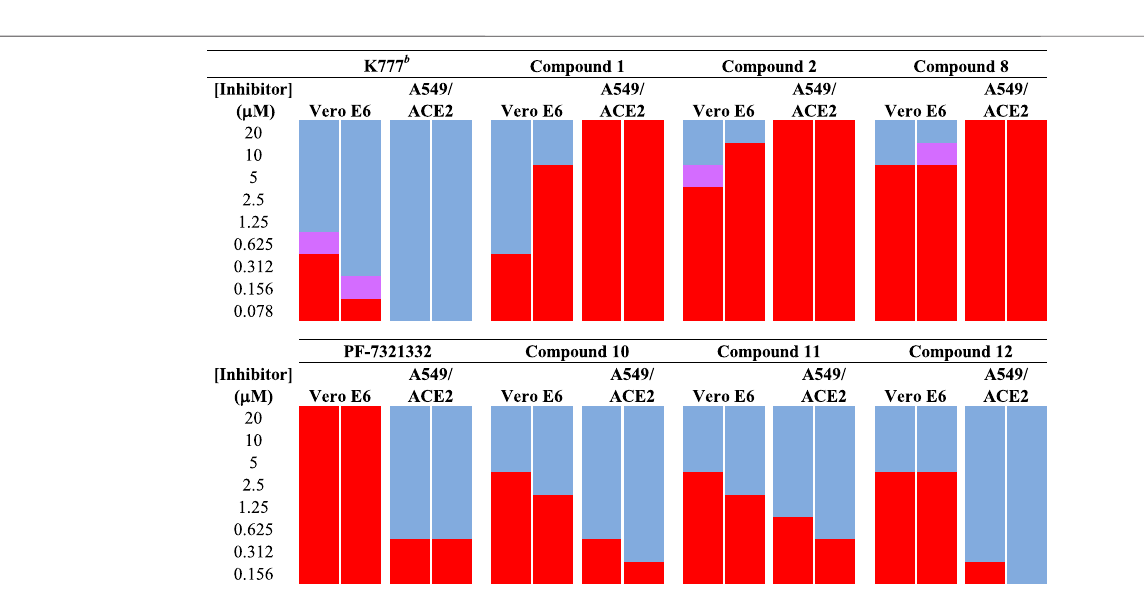
FIGURE 3| Anti-SARS-CoV-2 activity ofSMAIs, compared to that of K777 and PF-07321332 . SARS-CoV-2-infected VeroE6 and human A549/ACE2cells were treated as described with K777 , aldehyde 1 , SMAIs 2 , 8 , and the pro-drug forms of 8 , compounds 10-12 .